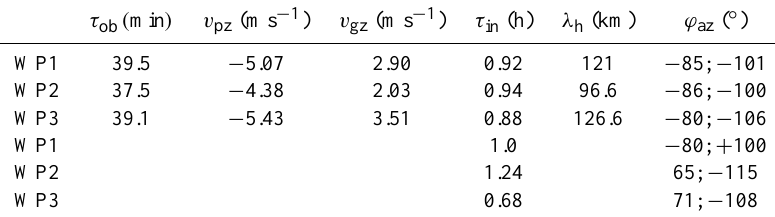
Table 3. 2nd to 4th rows are the measured values of observed period (2nd column), vertical phase velocity (3rd column), and vertical group velocity (4th column) of the three upward wave packets in Fig. 1a, and their intrinsic period (5th column), horizontal wavelength (6th column) and azimuths (7th column) obtained by the dispersion relation. 5th to 7th rows are the corresponding values obtained by Stokes parameters